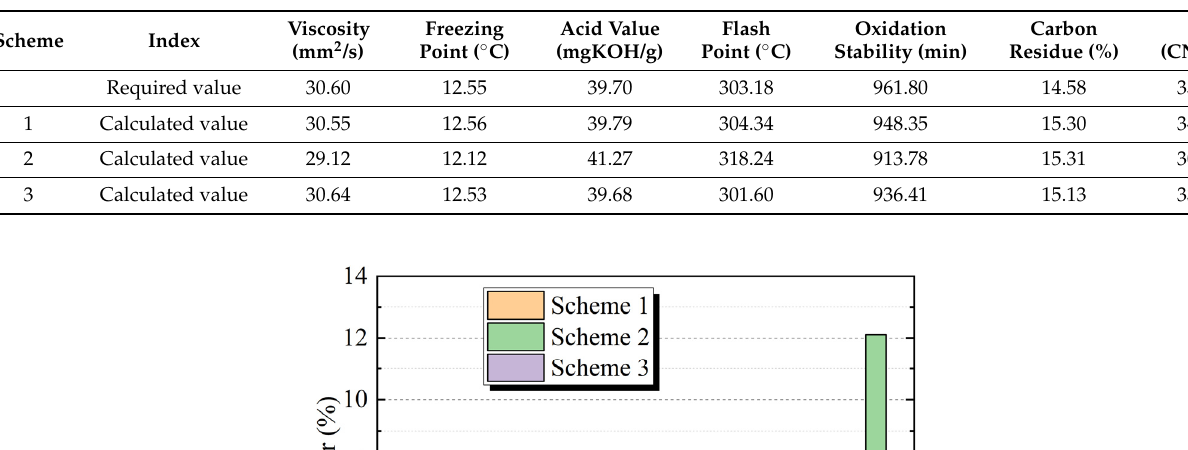
Table 6. Comparison of the calculated and required values of product performance indexes under the three blending schemes.